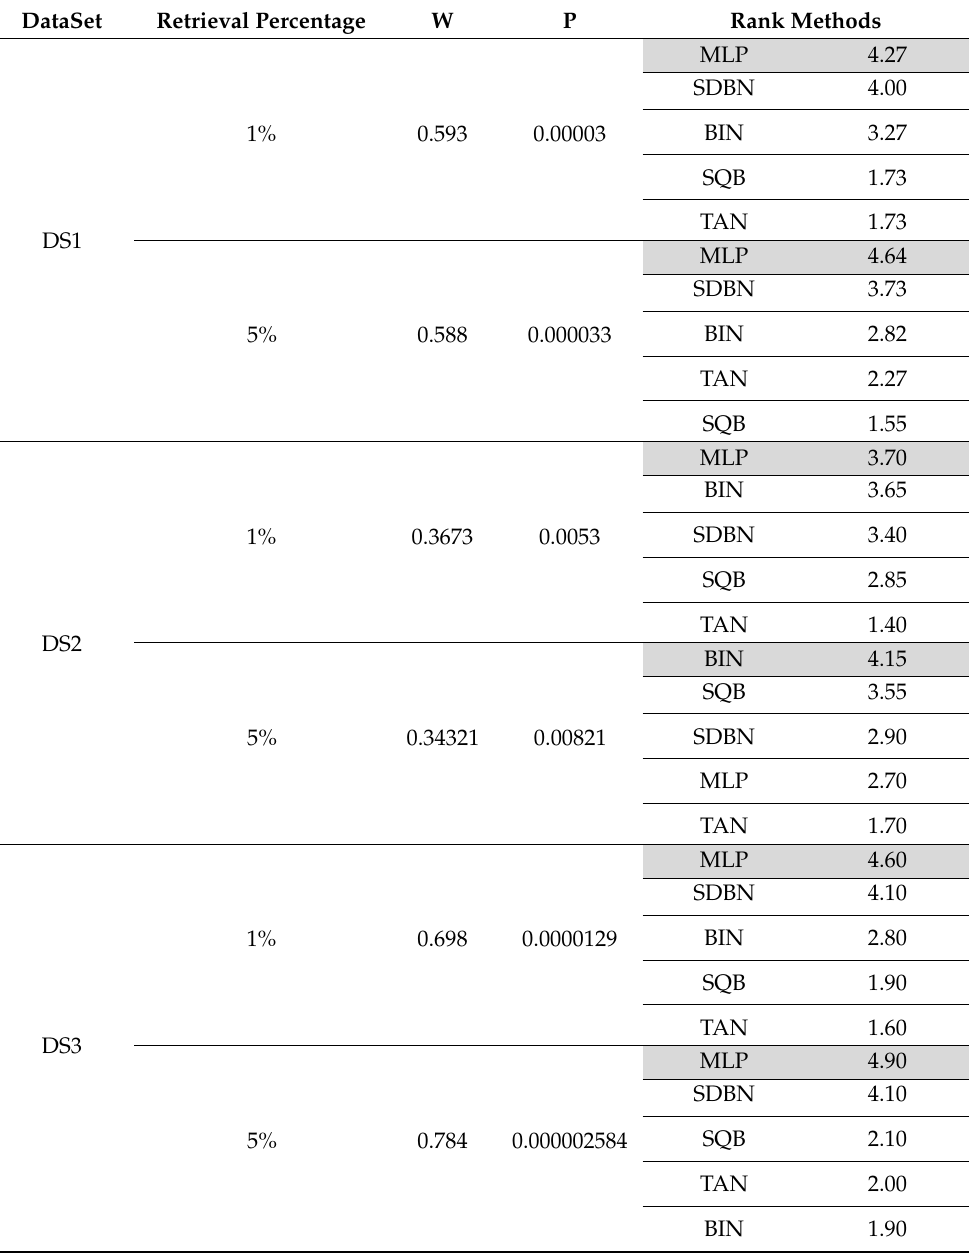
Table 16. Ranking of enhanced Siamese multilayer perceptron method based on previous studies TAN, BIN, SQB, and SDBN using Kendall W test